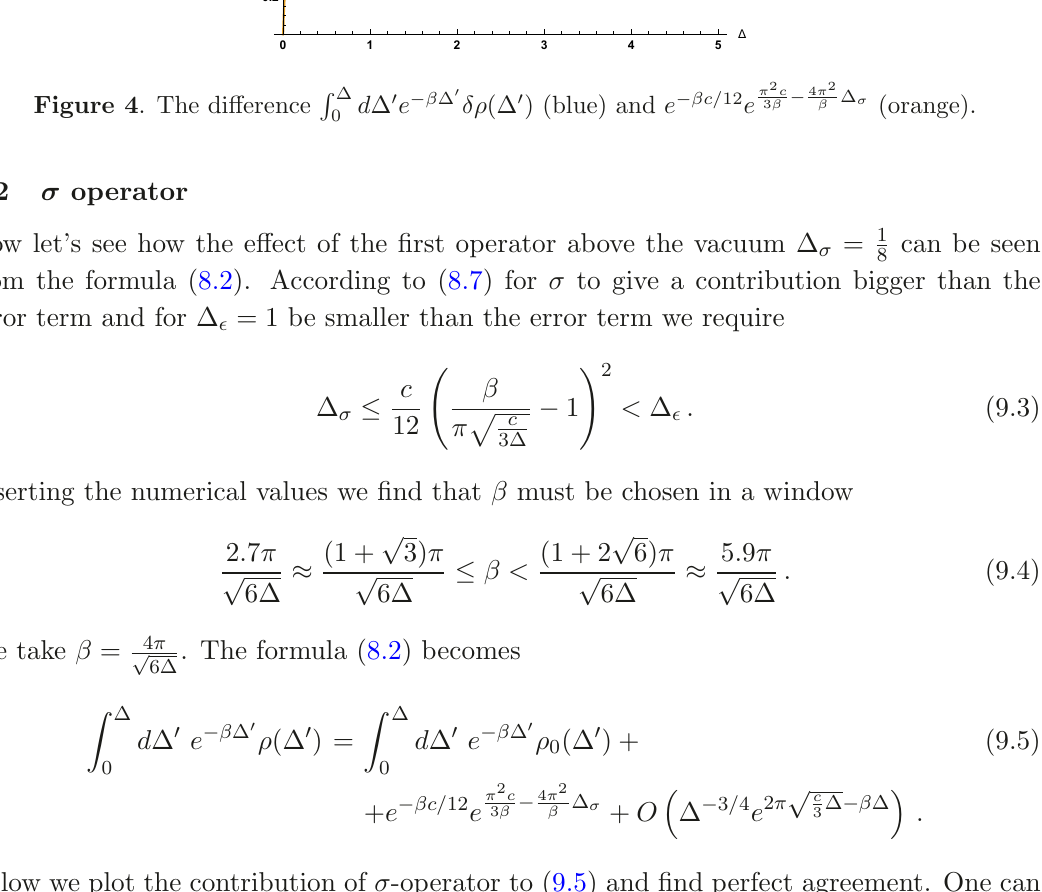
2 c − 4 π 2 3 β β ∆ σ